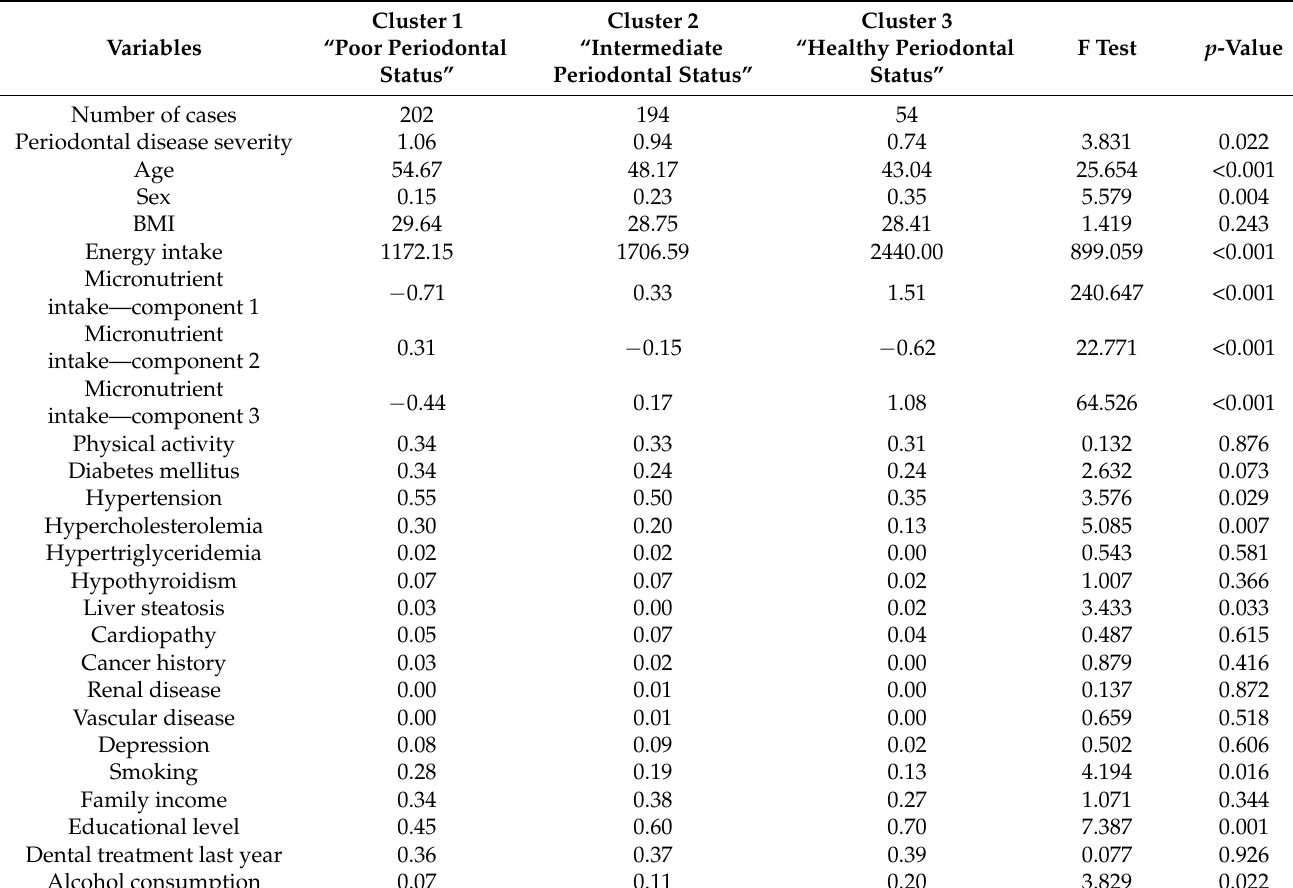
Table 3. Final cluster centers (means) of the social health-related variables (important differences which identify the clusters are shown in a dark gray